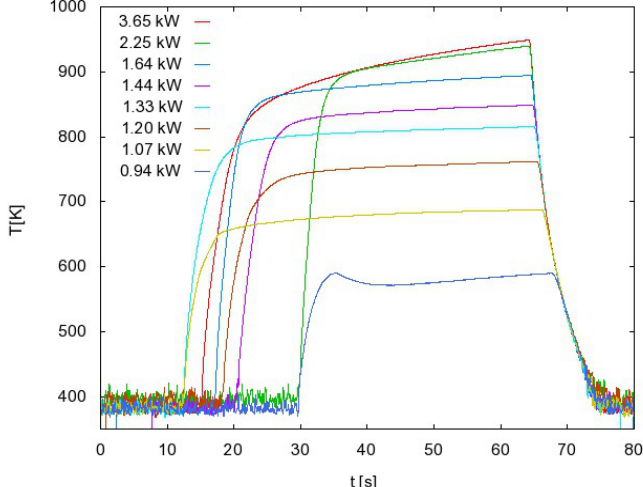
Figure 4. Temperature measurements of the probe versus time, the RF generator power is the parameter. Pressure is 55